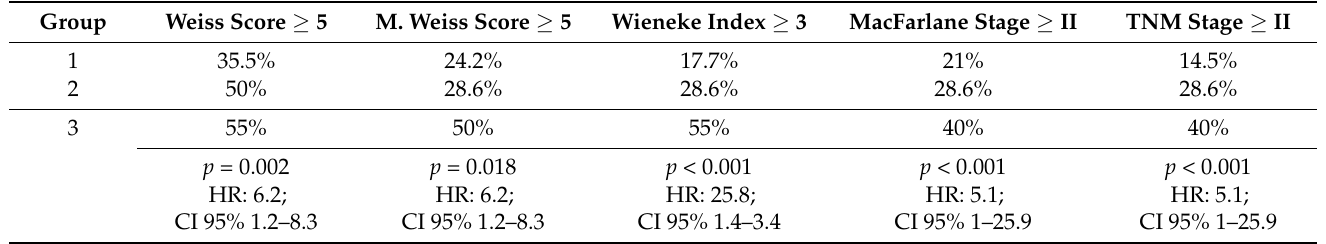
Table 4. Percental of the different staging of patients with PACTs divided in three different